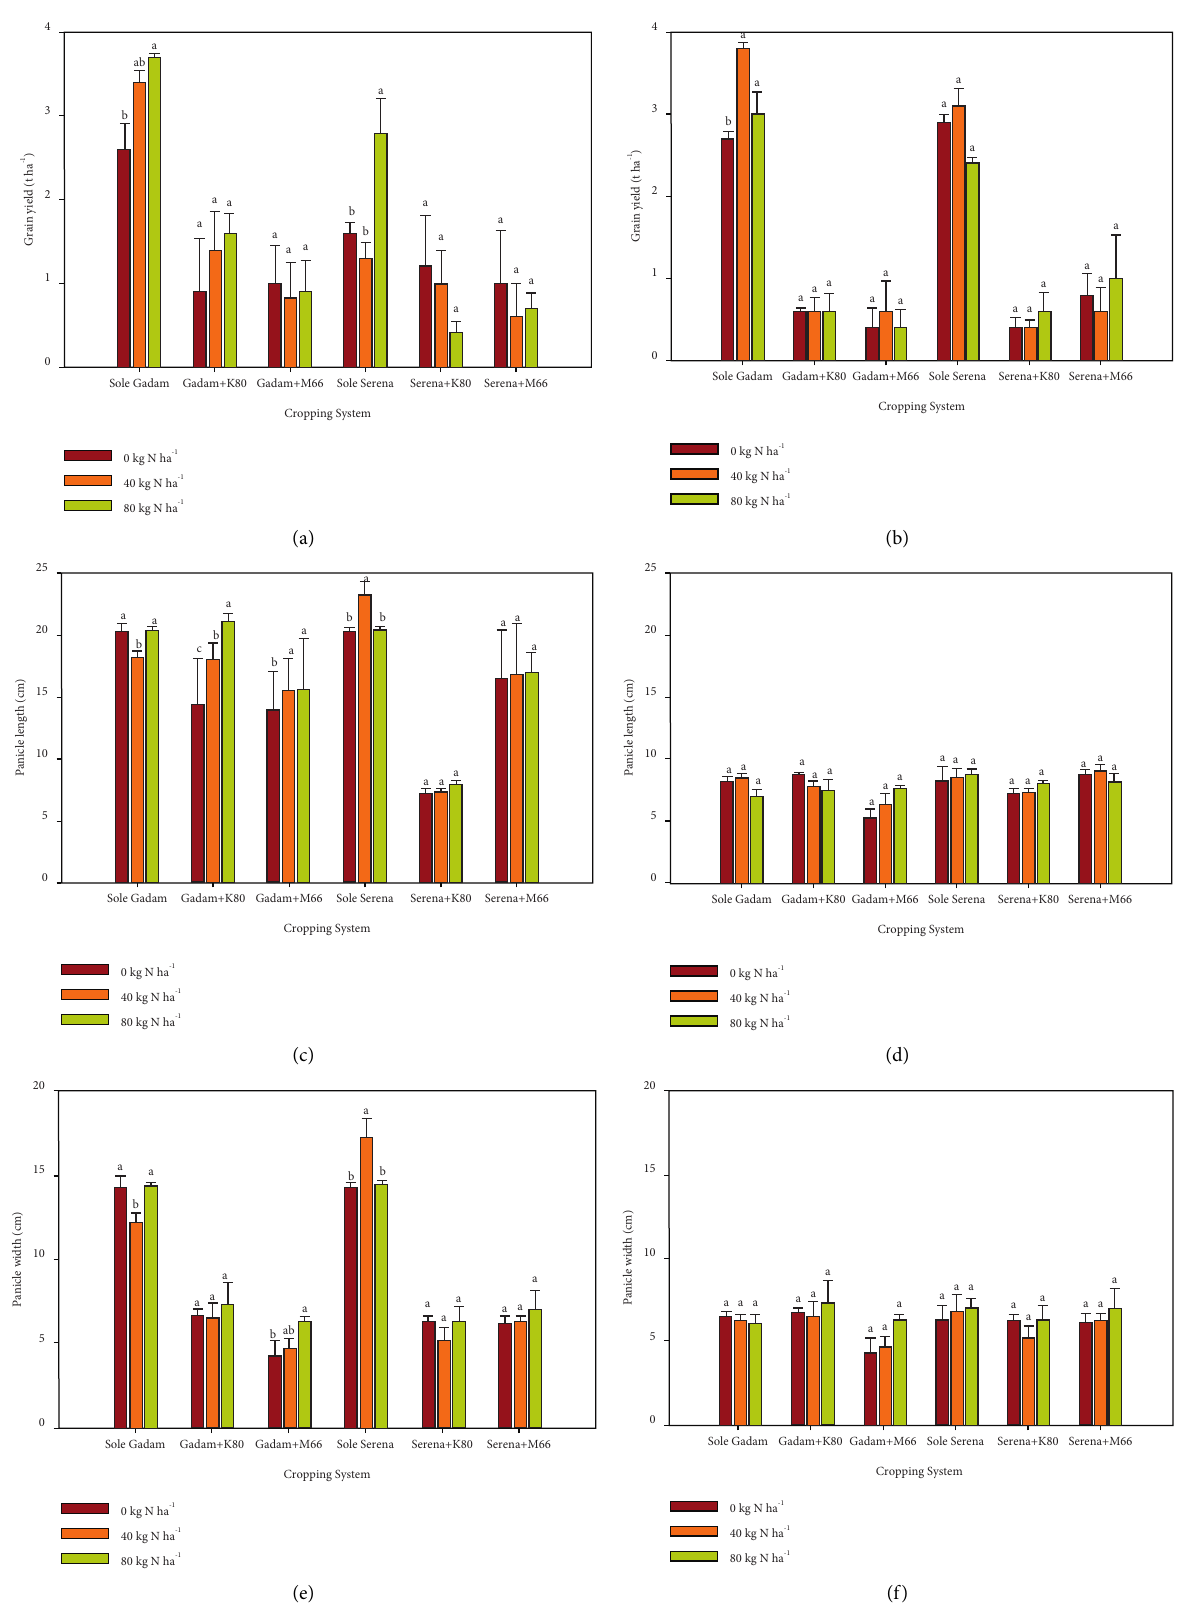
Figure 1: Sorghum grain yield, panicle width, and panicle length of two sorghum varieties (Gadam and Serena) grown in sole and intercrop system with two varieties of cowpea (K80 and M66) in interaction with 0, 40, and 80kg · N · ha − 1 at the KALRO, Igoji (a, c, e) and Katumani (b, d, f) research station during 2018/2019 short rains season. Mean values followed by the same letter are not significantly different. The bars indicate the mean standard errors